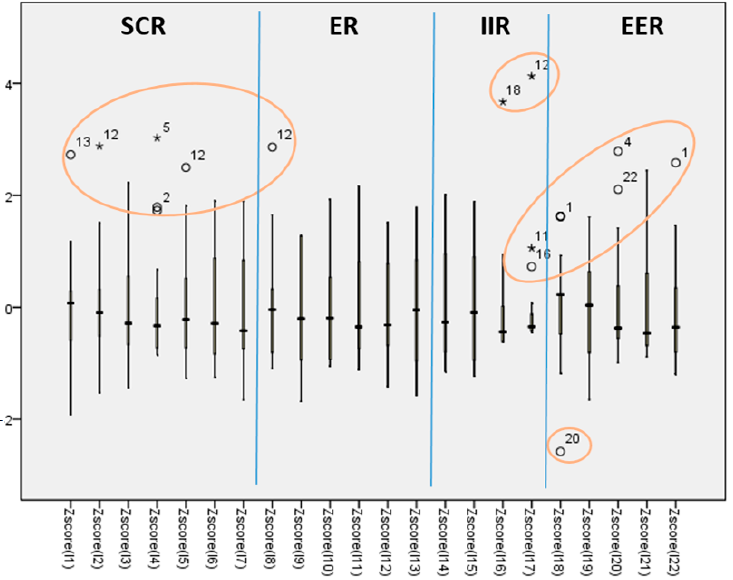
Figure 3. The standardized distribution of resilience indicators. * Plots in circle and star indicate outliers based on their divergence from mean.